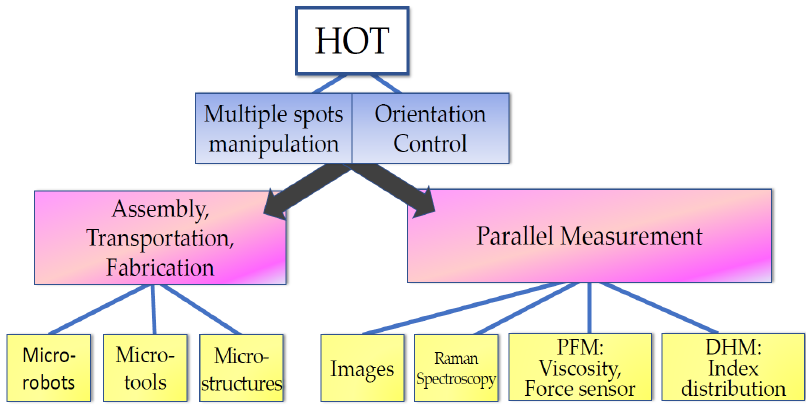
Figure 6. Bio-applications of HOT.